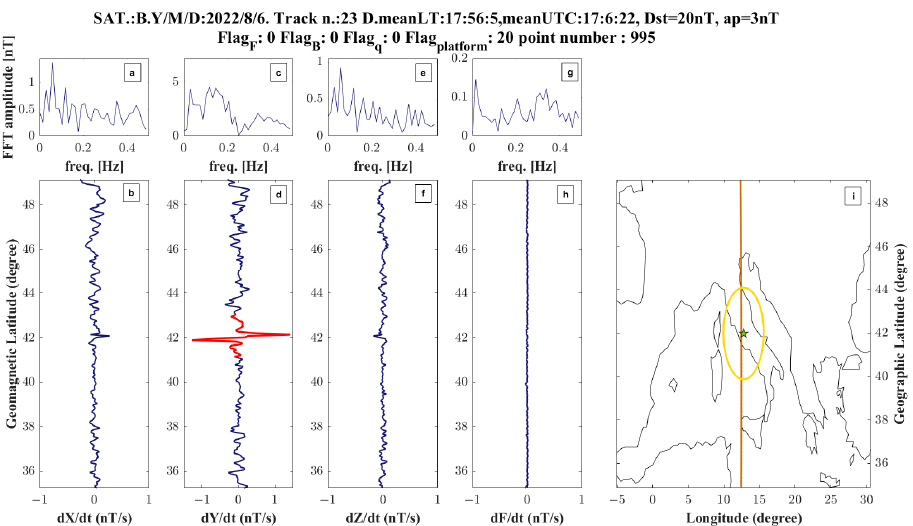
Figure 9. Swarm Bravo magnetic field analysis on 6 August 2022, track 23. The title reports the first satellite letter, date of acquisition, track number, mean local time and UT time, geomagnetic indexes, and the total number of original samples acquired with anomalous ESA Swarm data quality flags. Map ( i ) shows the projection of the satellite track in brown, and eventual anomalous flags are marked with red. The green star represents the epicentre of the M3.3 Guidonia 1 January 2023 earthquake, and the yellow circle is the Dobrovolsky of an earthquake of magnitude 4.1. The residuals of geomagnetic signals for X-North ( b ), Y-East ( d ), Z-Center ( f ) and F absolute scalar intensity ( h ) are represented with blue lines on the left, in correspondence with the map, and eventual anomalies inside the research area are marked with red lines. A spectrum of the signal made by Fast Fourier Transform (FFT) inside the minimum and maximum latitudes of the area is reported in ( a ), ( c ), ( e ) and ( g ) subfigures for X, Y, Z and F, respectively.